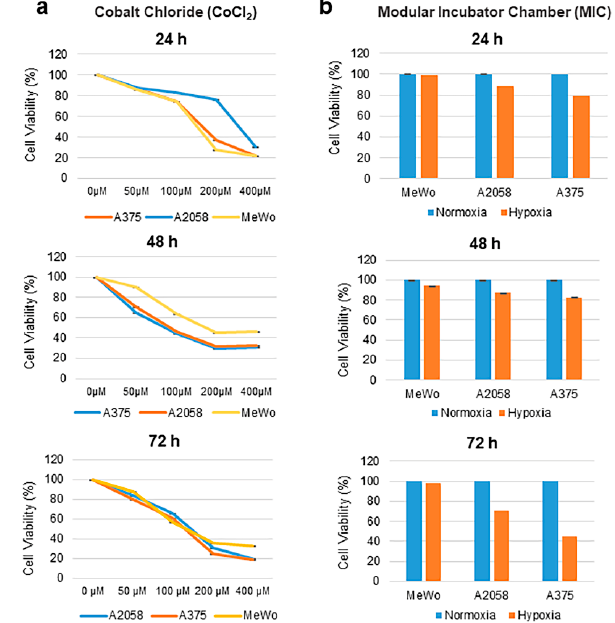
Figure 1. Effect of cobalt chloride (CoCl 2 ) and hypoxia on melanoma cell viability. ( a ) A2058, A375 and MeWo cells were treated with CoCl 2 at increasing concentrations (0, 50, 100, 200, 400 µM) for